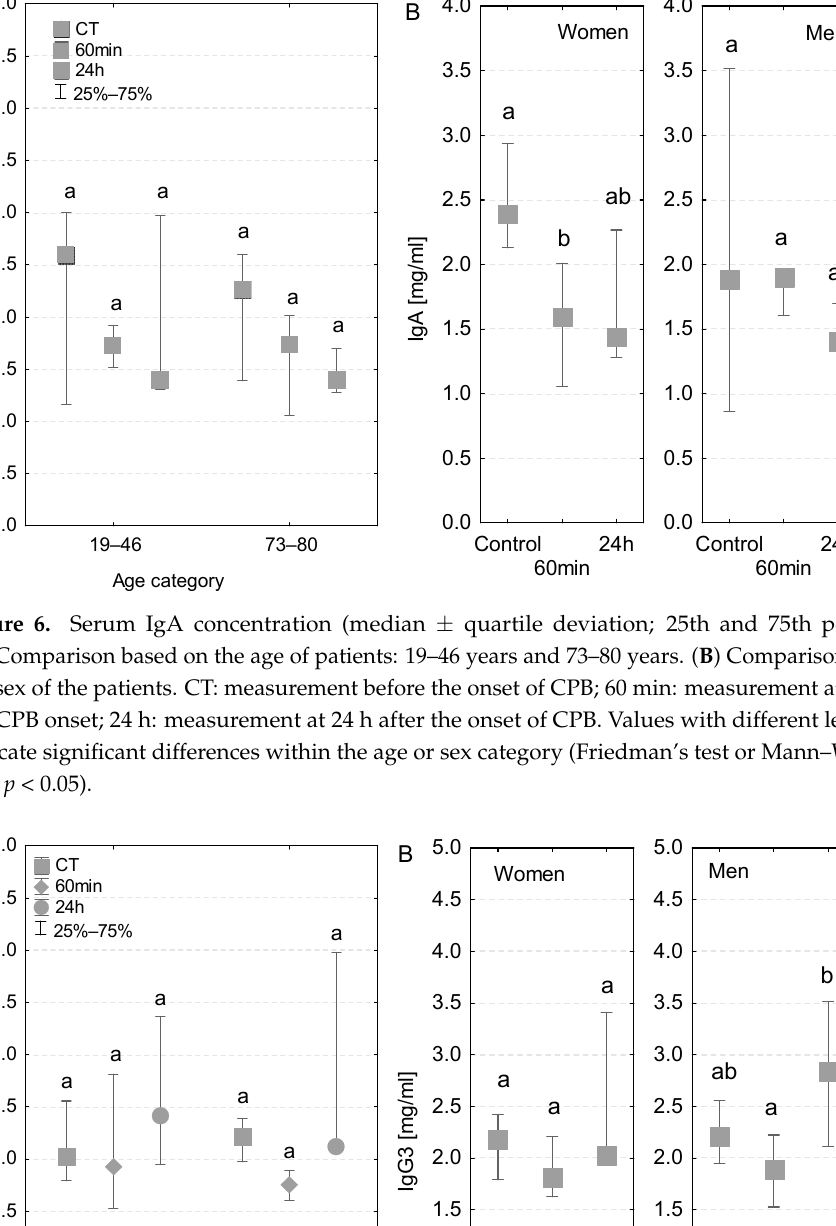
9 of 14 Figure 5. Serum IgE concentration (median ± quartile deviation; 25th and 75th percentiles). ( A ) Com- parison based on the age of patients: 19–46 years and 73–80 years. ( B ) Comparison based on the sex of the patients. CT: measurement before the onset of CPB; 60 min: measurement at 60 min of the CPB onset; 24 h: measurement at 24 h after the onset of CPB. Values with di ff erent le tt ers (a,b) indi- cate signi fi cant di ff erences within the age or sex category (Friedman’s test or Mann–Whitney U test; p < 0.05). 3.6. IgA The IgA concentrations measured in the analyzed age groups were generally within the reference range (1–3 mg/mL). The concentrations of IgA antibodies measured in serum at both 60 min of the CPB onset and 24 h after the beginning of the surgery were lower compared to the control measurements. The level of IgA antibodies was also within the reference range in the serum of patients with diagnosed postoperative infection (Table 3), but in this group the values decreased in subsequent time points (Figure 6A). In women,